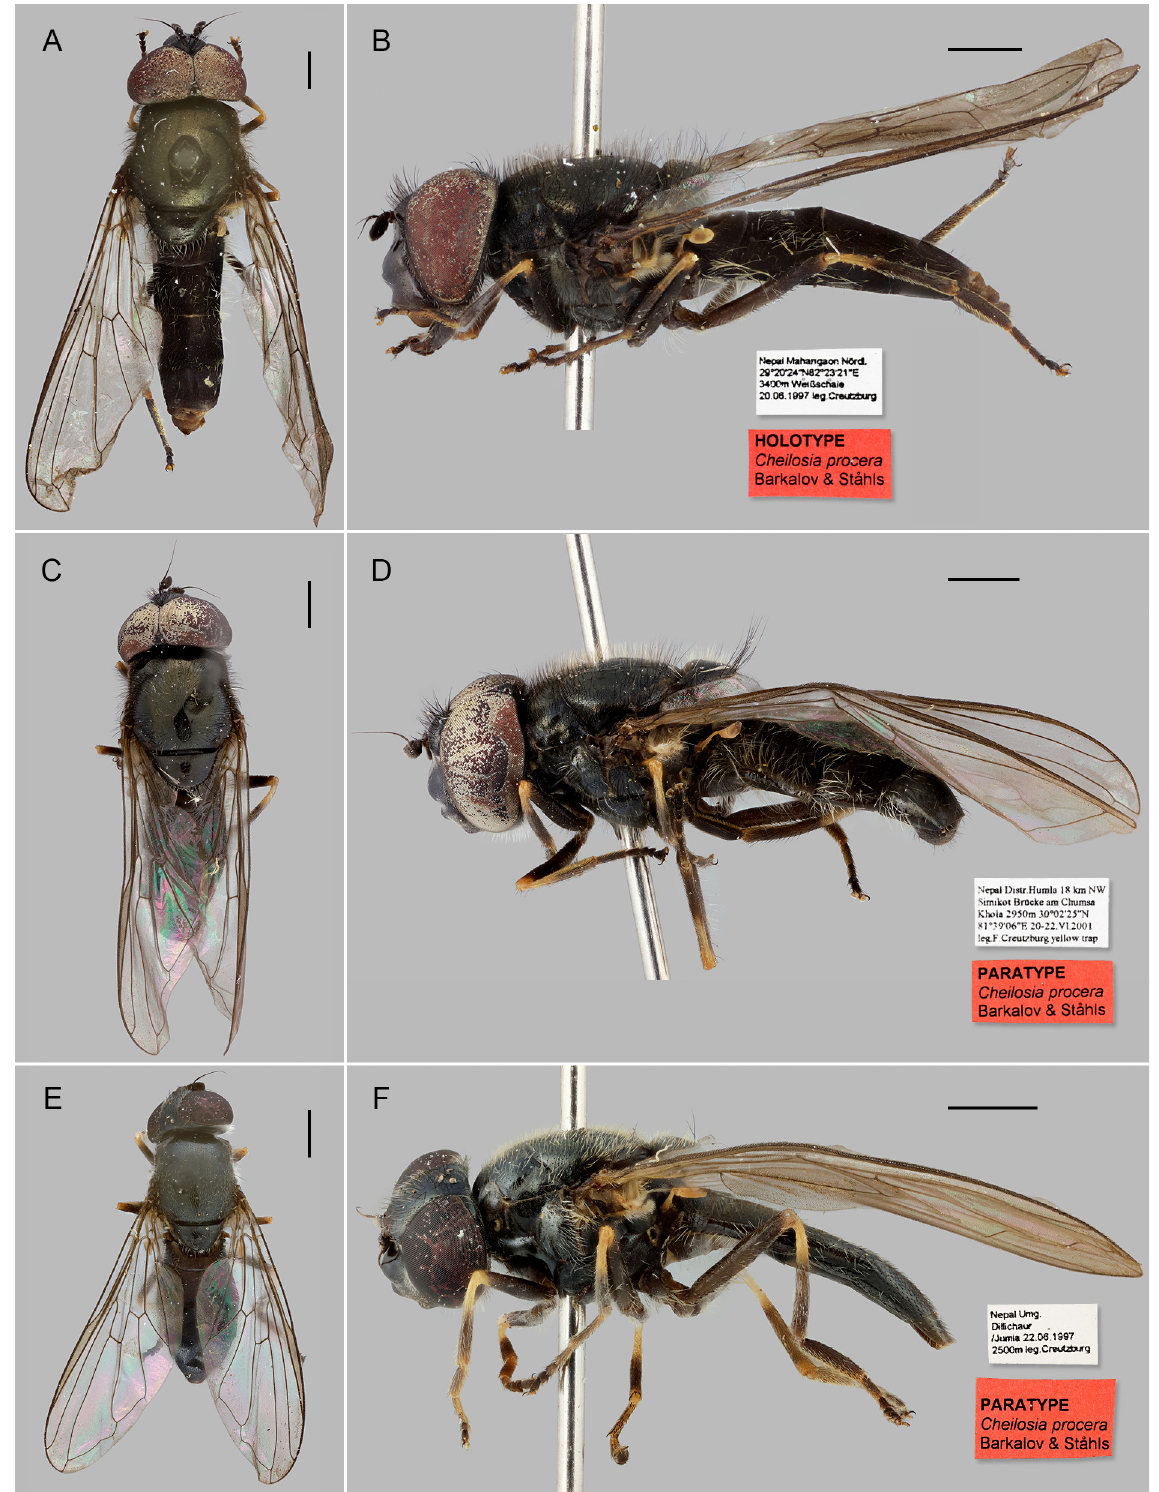
Fig. 55. Cheilosia ( Eucartosyrphus ) procera sp. nov. A–B . Holotype, ♂ (IBSJW/NME); dorsal and lateral views. C–D . Paratype, ♂ (IBSJW/NME); dorsal and lateral views. E–F . Paratype, ♀ (IBSJW/NME), dorsal and lateral views. Photo: Pekka Malinen, FMNH Luomus. Scale bars = 1